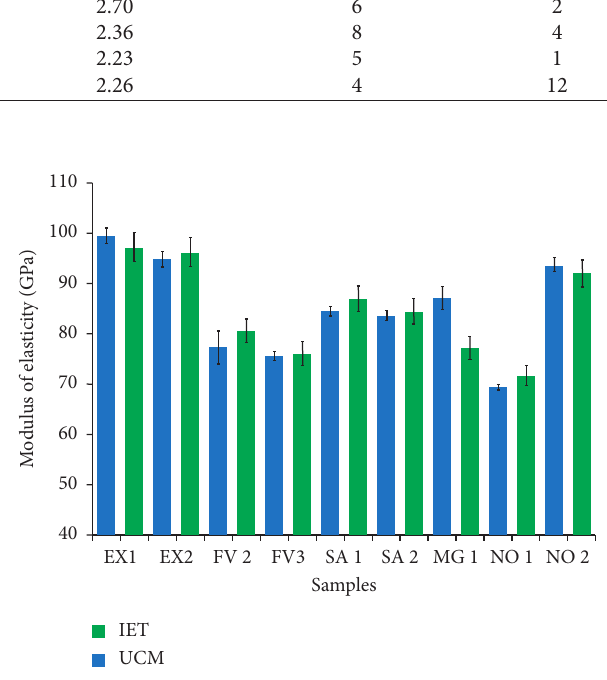
Figure 4: Elasticity modulus determined by UCM and IETand the standard